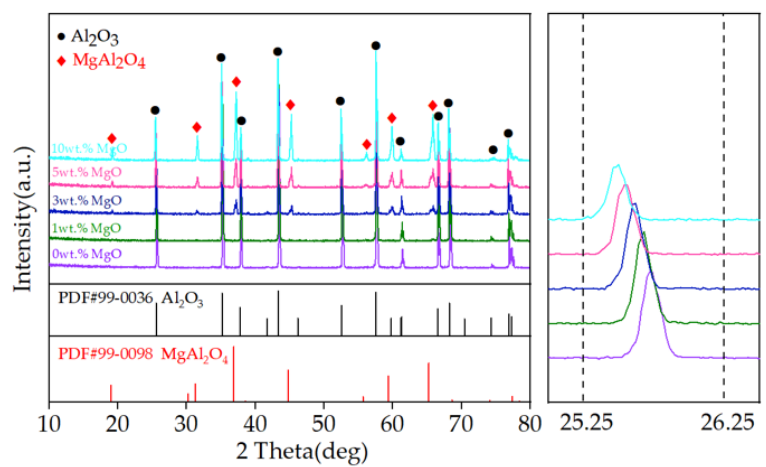
Figure 1. XRD patterns of MgO-doped Al 2 O 3 ceramic pellets.